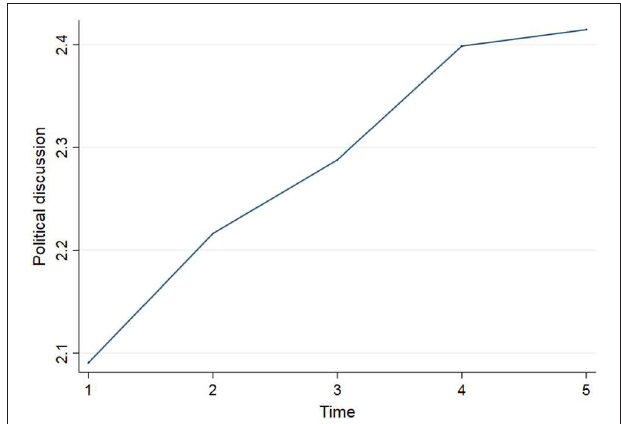
FIGURE 2 | Average levels of political discussion T1-T5.